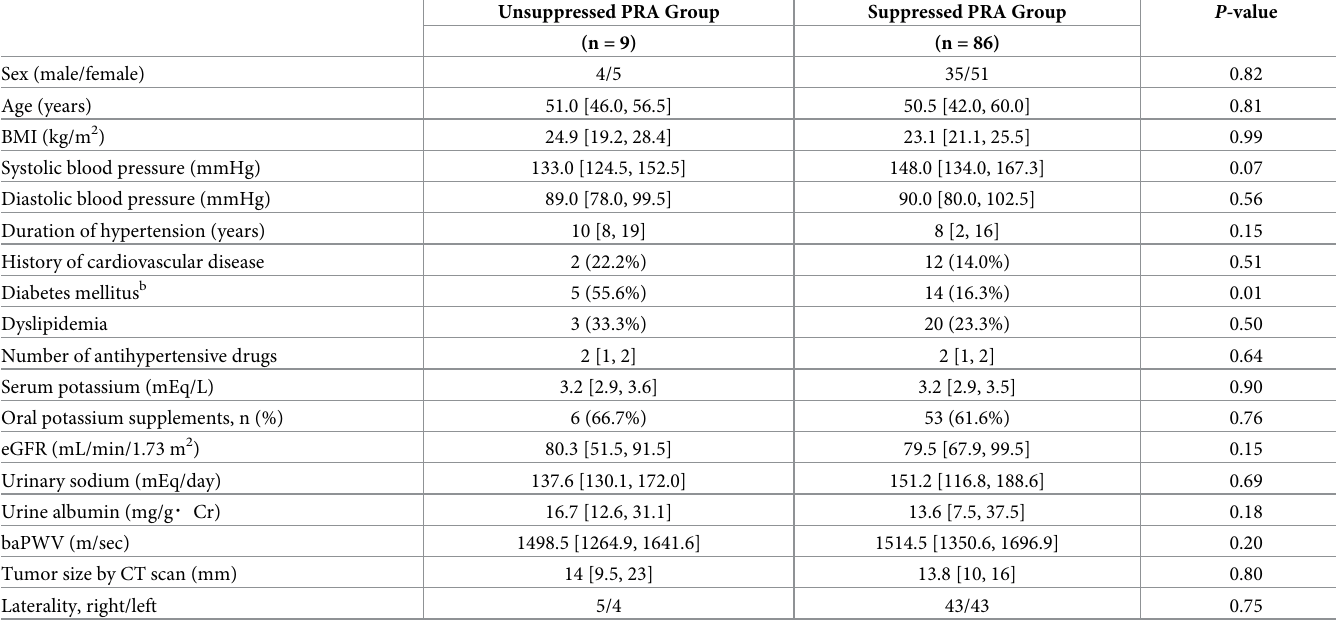
PRA, plasma renin activity; BMI, body mass index; eGFR, estimated glomerular filtration rate; baPWV, brachial-ankle pulse wave velocity; CT, computed tomography. a Continuous variables are shown as median [interquartile range] for non-normal distributions. b Diabetes mellitus included borderline diabetes